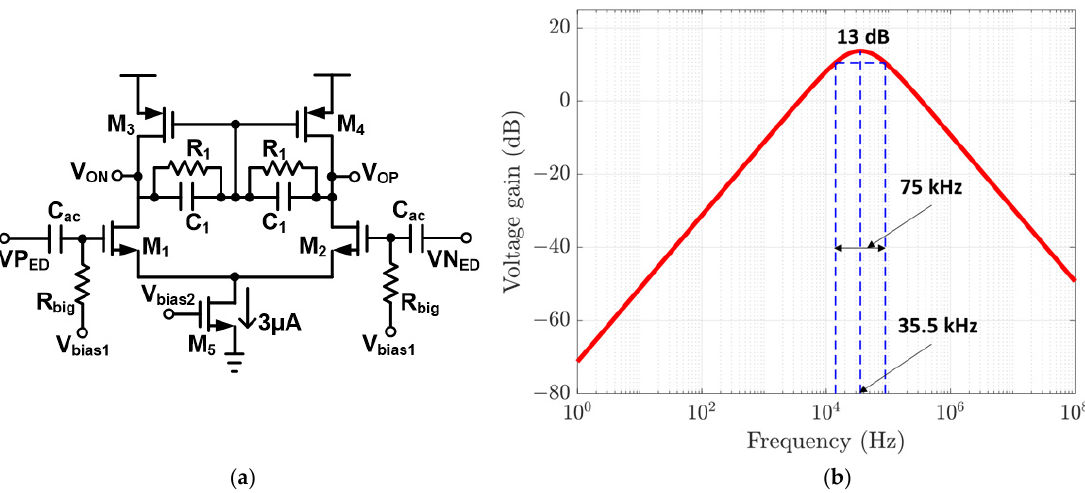
Figure 5. Schematic and simulation result of designed baseband amplifier: ( a ) schematic and ( b ) frequency response.